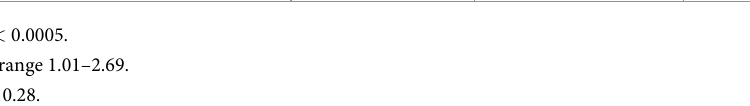
Table 5. Analysis of variance table for the Fisher Success model. The dependent variable was landed weight of sea bass per meter of vessel. Predictor Df Sum Sq Mean Sq Pr( > F) Wave height (As factor) 4 Change in fish price Vessel ID